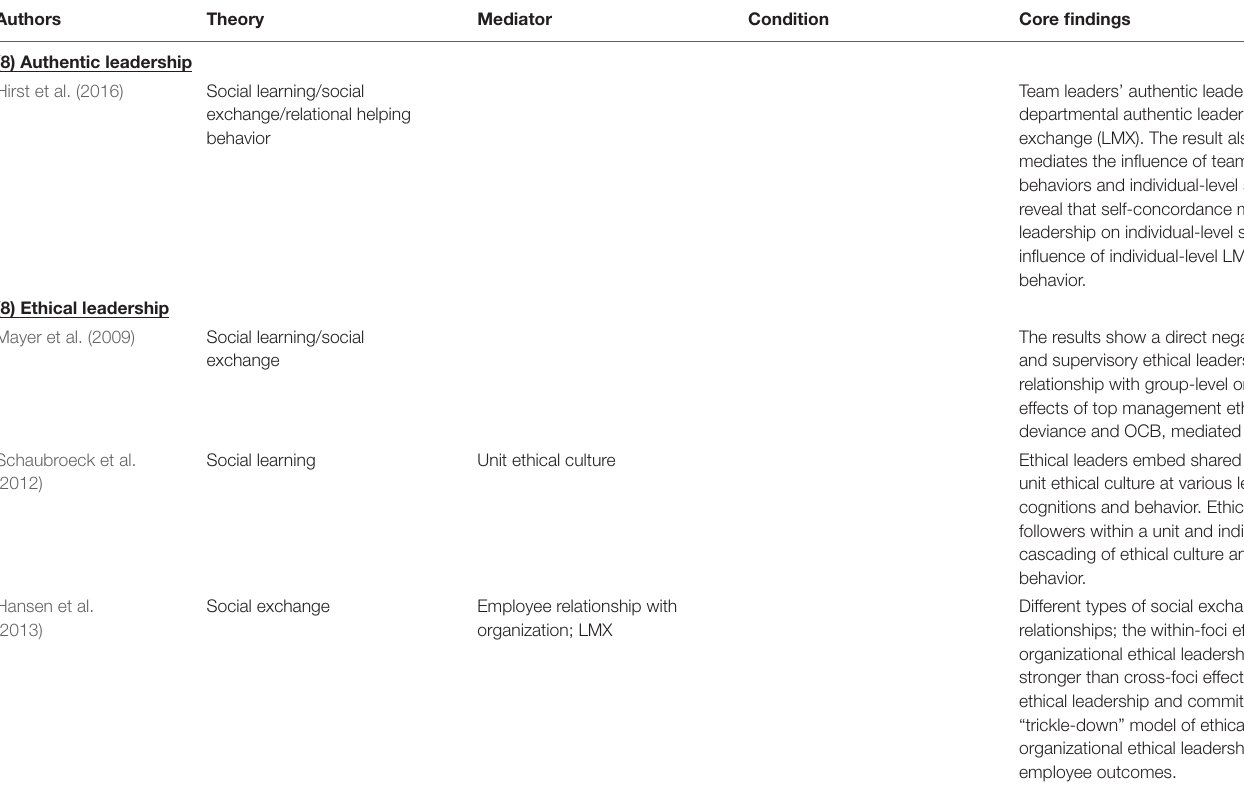
TABLE 2 | Cascading research and its